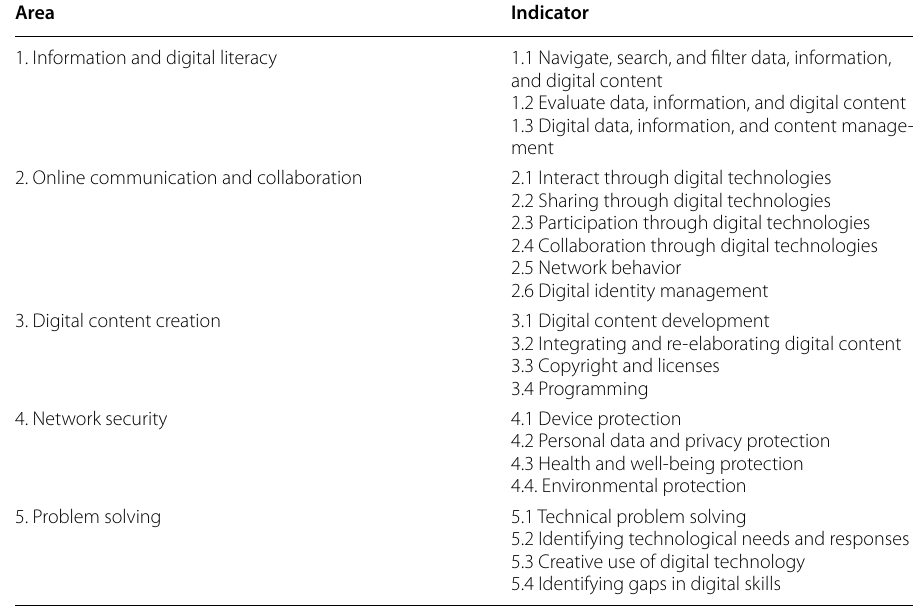
Table 2 Area and Indicator DIGCOMP. Source: Prepared by the author